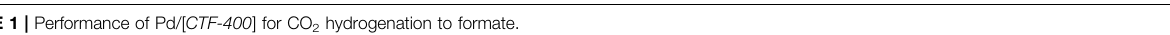
TABLE 1 | Performance of Pd/[ CTF-400 ] for CO 2 hydrogenation to